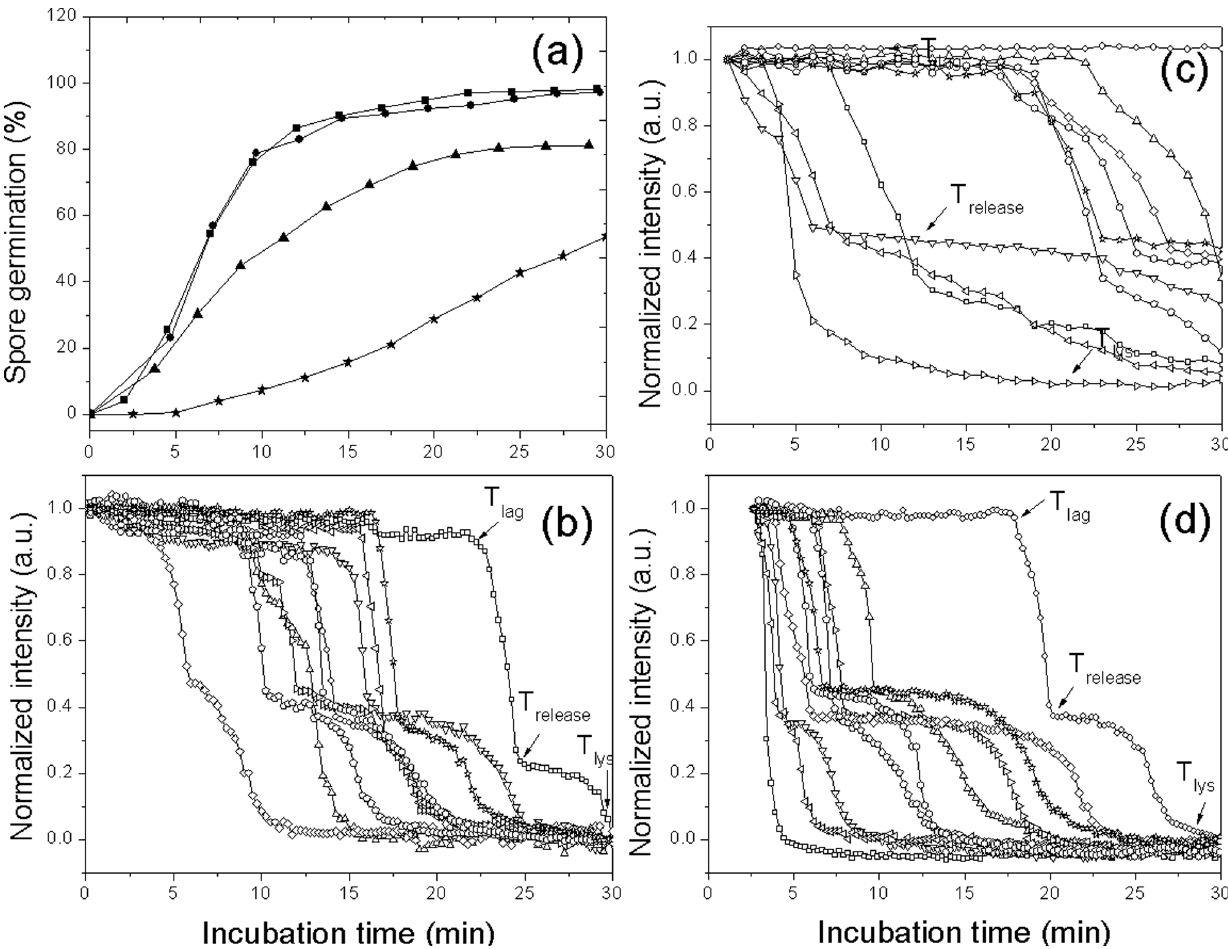
Figure 3. Effects of different activation methods on germination of multiple individual G.stearothermophilus spores. Spores were activated by various methods, and germinated at 65 u C with 1.0 mM L-valine and 10 mM sodium phosphate buffer (pH 8.0), and germination of N individual spores was monitored by DIC microscopy as described in Methods. Germination of $ 248 individual spores (Table 2) that were activated in ), in water at 30 u C for 120 h ( m ), in water at 100 u C for 30 min ( & ), or without activation (*) was 0.2 M sodium nitrite (pH 8.0) at 30 u C for 17 h ( shown in (a). Kinetics of germination of ten individual spores without activation (b); activated at 30 u C for 120 h (c), and activated in 0.2 M sodium nitrite (pH 8.0) for 17 h (d) was given in